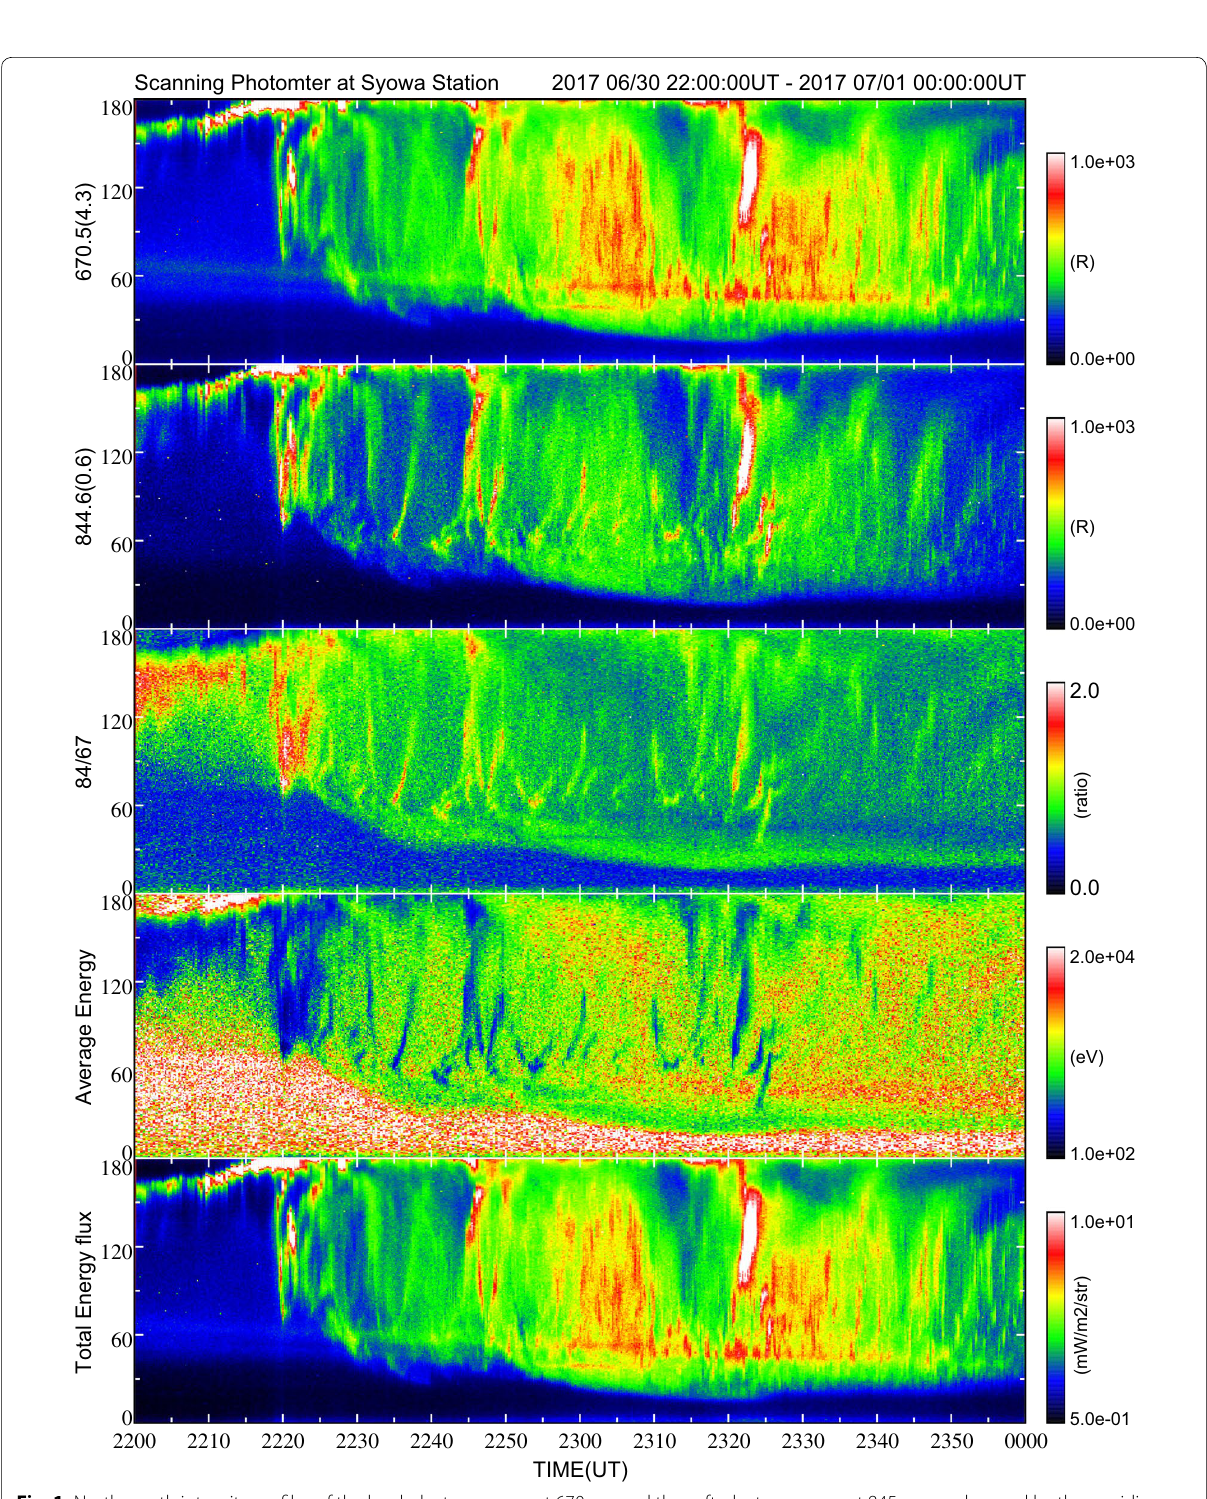
Fig. 1 North–south intensity profiles of the hard-electron aurora at 670 nm and the soft-electron aurora at 845 nm as observed by the meridian scanning photometer at Syowa Station (top two panels). A single north (0°) to south (180°, poleward) scan takes 10 s. The middle panel shows the ratio between the intensities of 670 nm and 845 nm. The bottom two panels show the estimated characteristic energy and total energy flux of auroral electrons as estimated from the two wavelengths (Ono 1993; Ono and Morishima